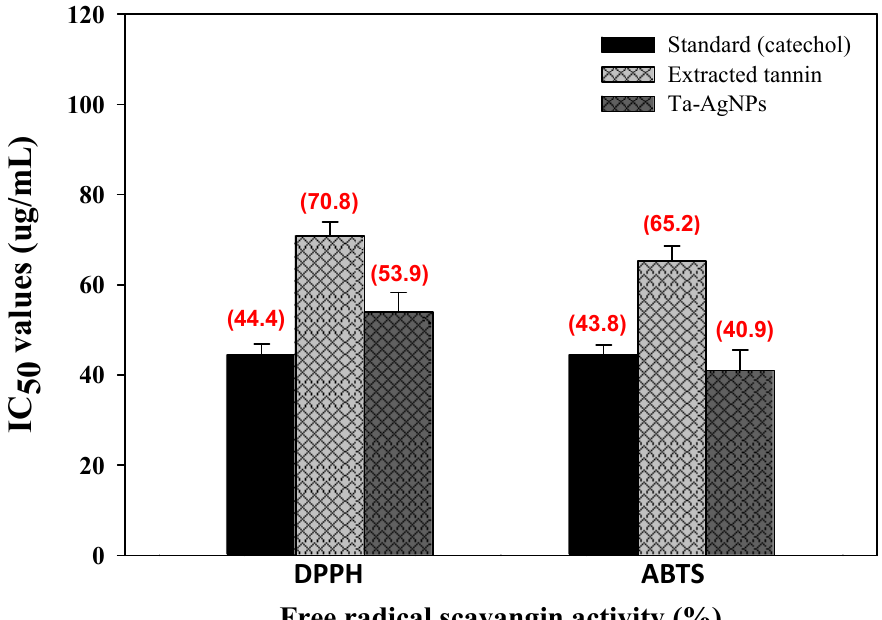
Figure 10. Antioxidant potential in terms of scavenging activity of synthesized Ta-AgNPs, extracted tannin, standard (catechol) against highly stable DPPH and ABTS and their IC 50 values.